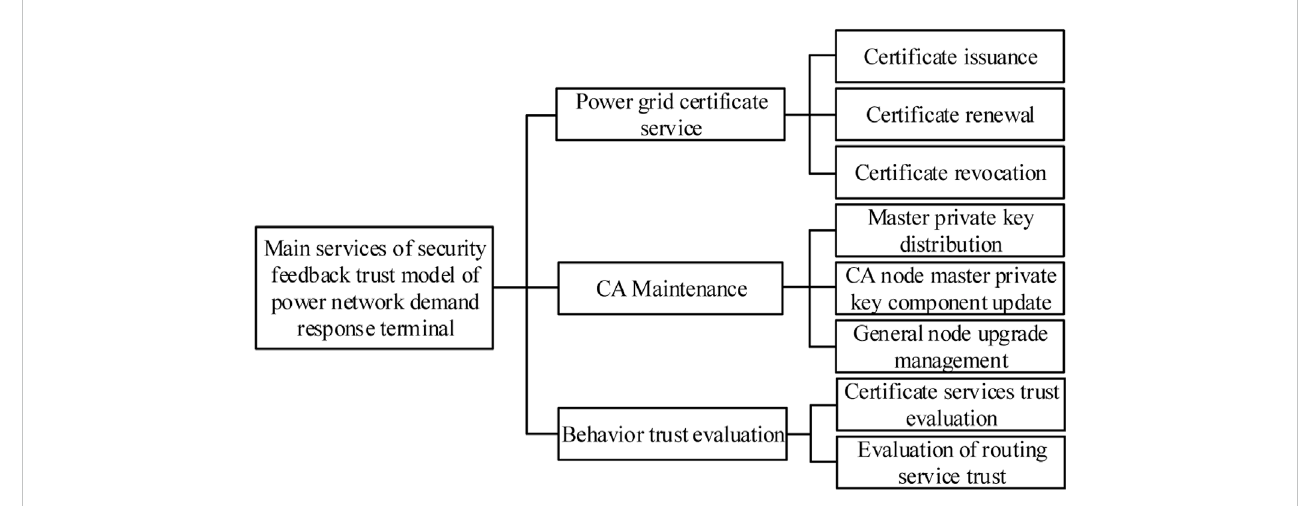
FIGURE 2 Main services of security feedback trust model of power network demand response